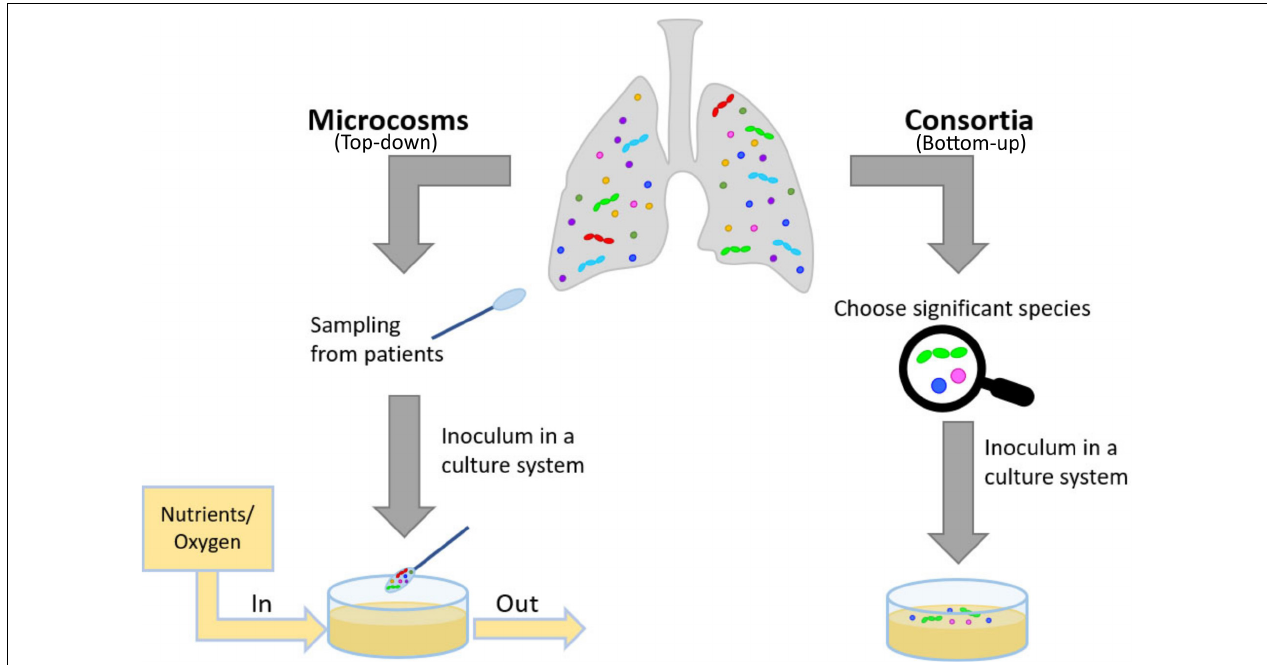
FIGURE 2 | Description of how to model in vitro physiological and pathological situations. In a top-down approach, the patient’s pool of bacteria is collected and cultured, ideally preserving its multimicrobial nature. In a bottom-up approach, the complexity of the physiological or pathological situation is reduced by introducing the main features fundamental for the study, e.g., selecting significant species and culturing in an appropriate substrate, possibly reproducing the 3D-environment of the